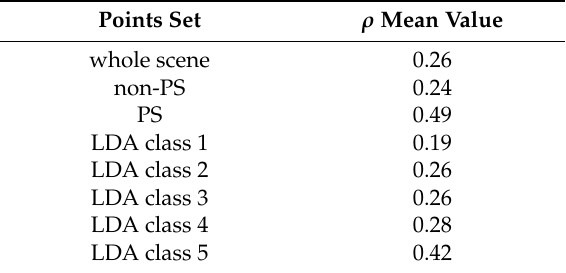
Table 5. Statistics of the global correlation